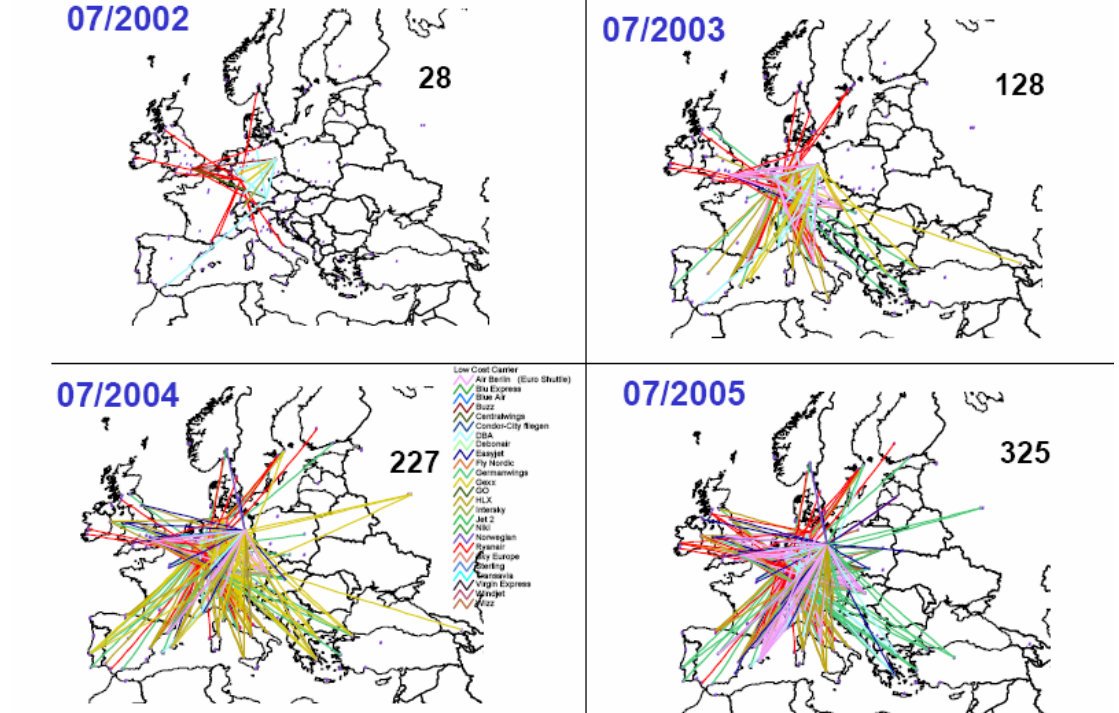
Figure 1. Development of LCC network in Germany for the period